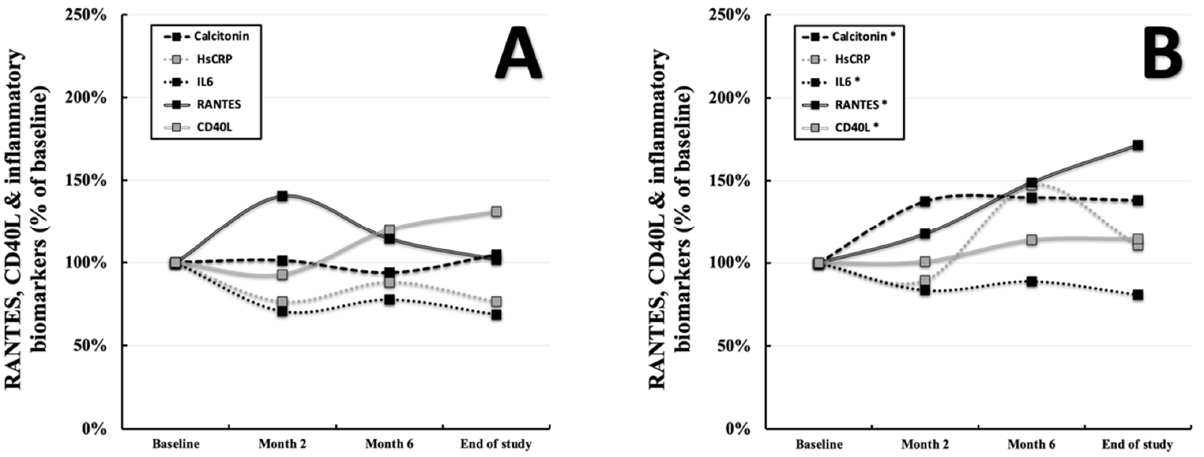
Figure 3. Progression of RANTES, CD40L, hsCRP, IL6, and calcitonin serum levels in groups A (performance gain of <3%, n = 27, ( A )) and B (performance gain of ≥ 3%, n = 71, ( B )) over the course of 8 months. “*” indicates a two-tailed p -value of p < 0.05 comparing baseline values to those at the end of the study.